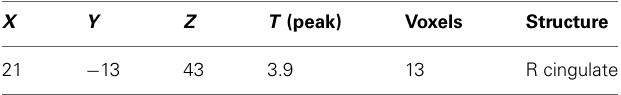
Table 5 | Brain activation due to ambroxan within a mixture in ambroxan insensitive subjects; contrast: INS: MIX + AMB vs. MIX (masked ALL vs. CON) ( p < 0 . 001; uncorrected).